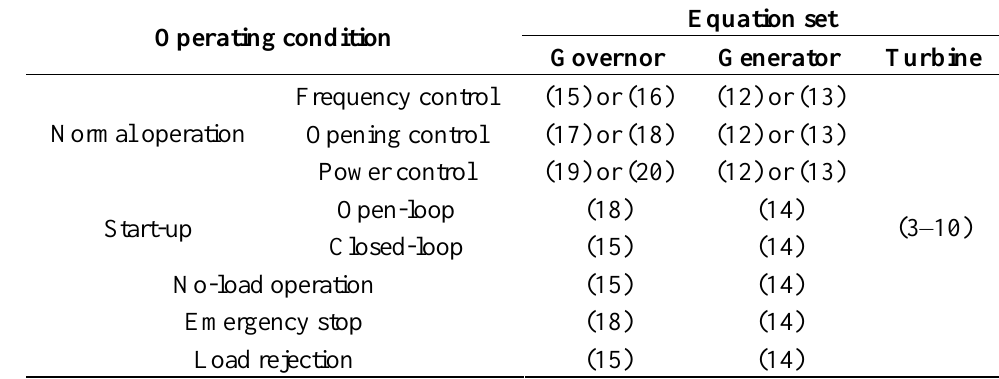
Table 4. Equation set of the hydro power unit under different operating conditions.